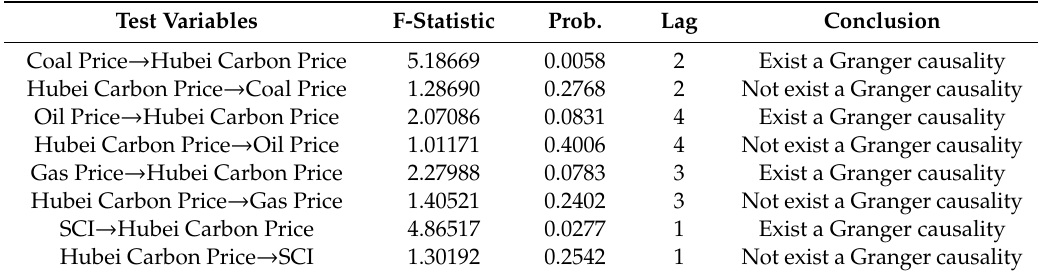
Table 6. Granger causality test results for the Hubei carbon price and its external factors.